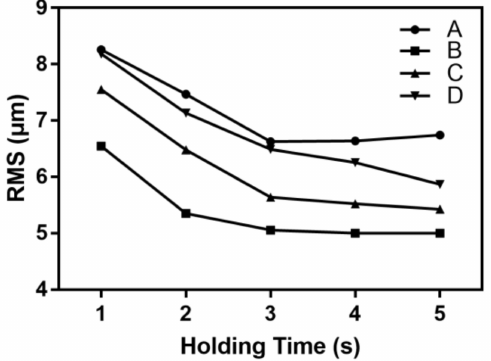
Figure 10. The influence of the holding time on the RMS of the